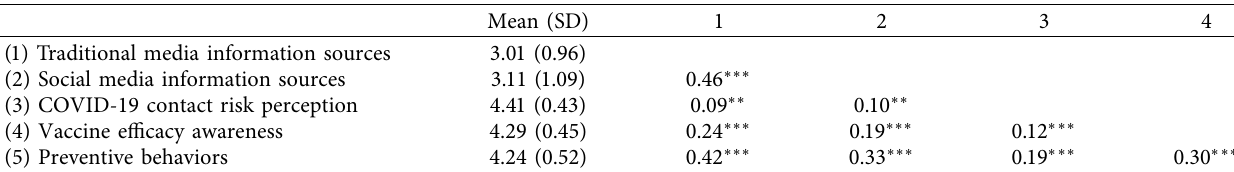
Table 11: Descriptive and bivariate correlations.